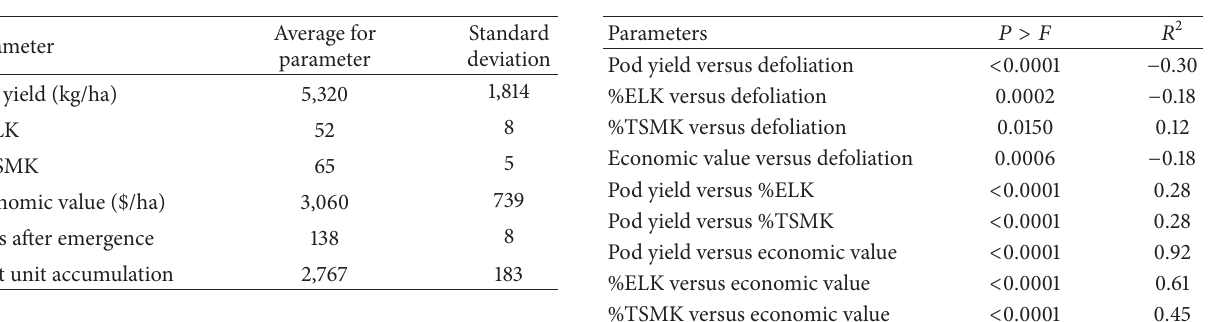
Table 4: Average and standard deviation for peanut yield, percent- ages of extra large kernels (%ELK) and total sound mature kernels (%TSMK),daysafterpeanutemergence,andheatunitaccumulation